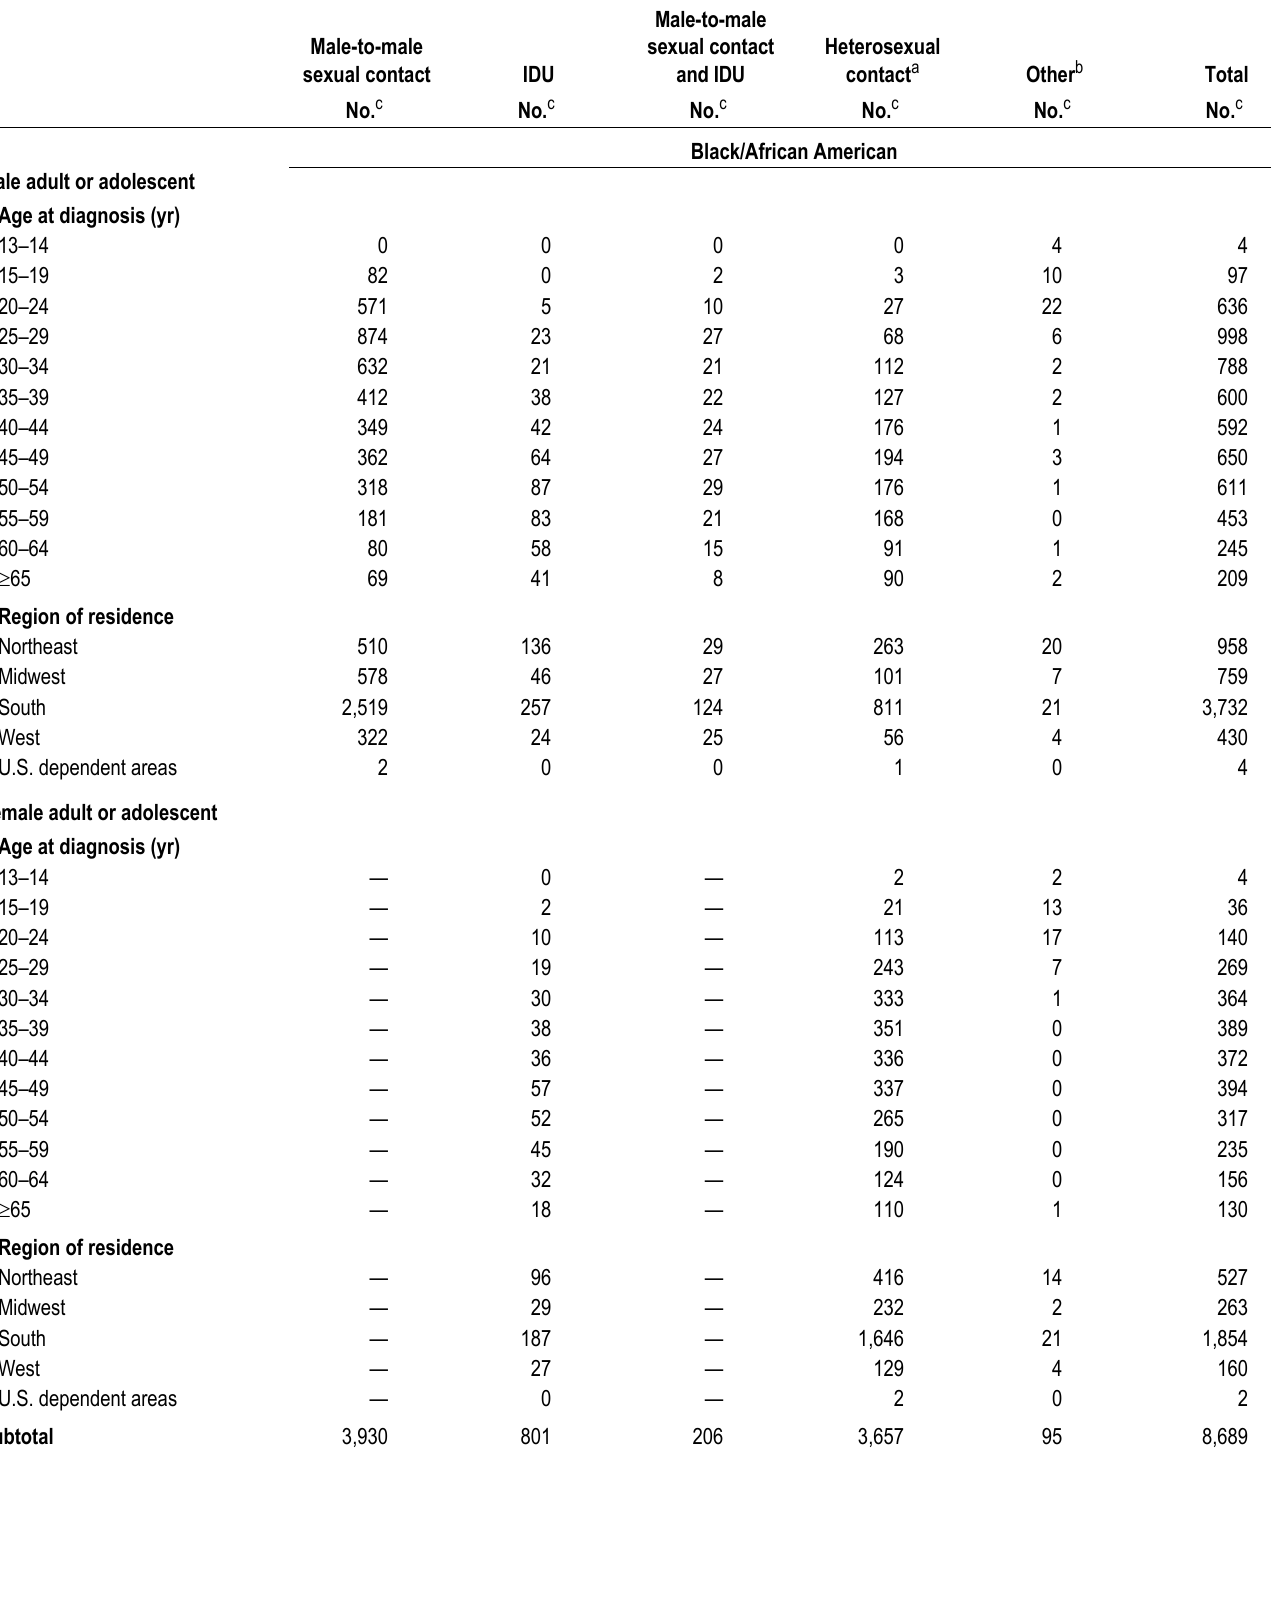
Table 6b. Stage 3 (AIDS), by transmission category, race/ethnicity, and selected characteristics, 2015—United States and 6 dependent areas